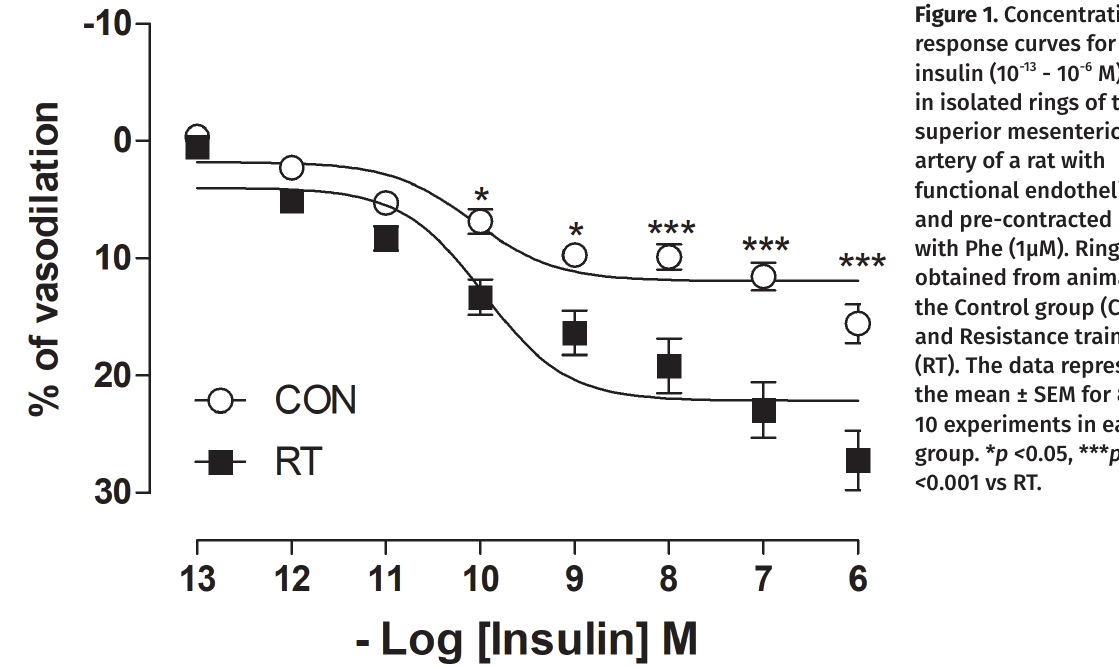
Figure 1. Concentration- response curves for insulin (10 -13 - 10 -6 M) in isolated rings of the superior mesenteric artery of a rat with functional endothelium and pre-contracted with Phe (1µM). Rings obtained from animals of the Control group (CON) and Resistance training (RT). The data represent the mean ± SEM for 8 - 10 experiments in each group. * p < 0.05, *** p < 0.001 vs